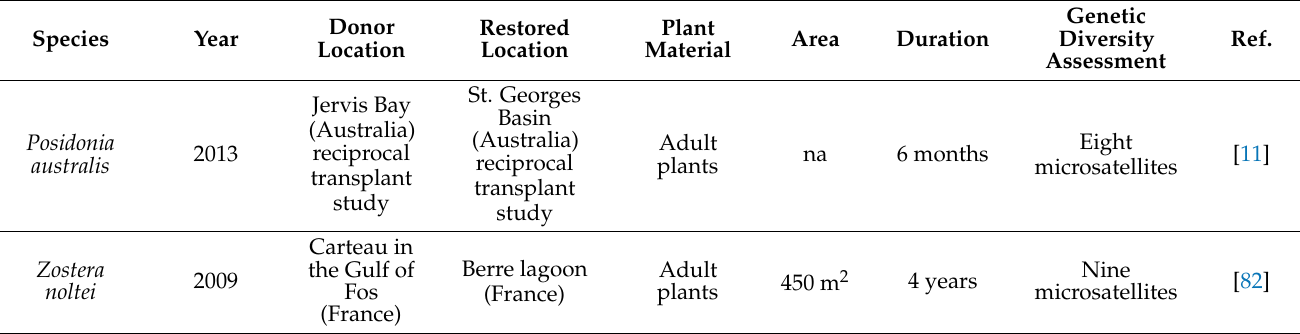
Table 1. List of the most relevant studies investigating the effects of genetic diversity on seagrass restoration plans. Data were